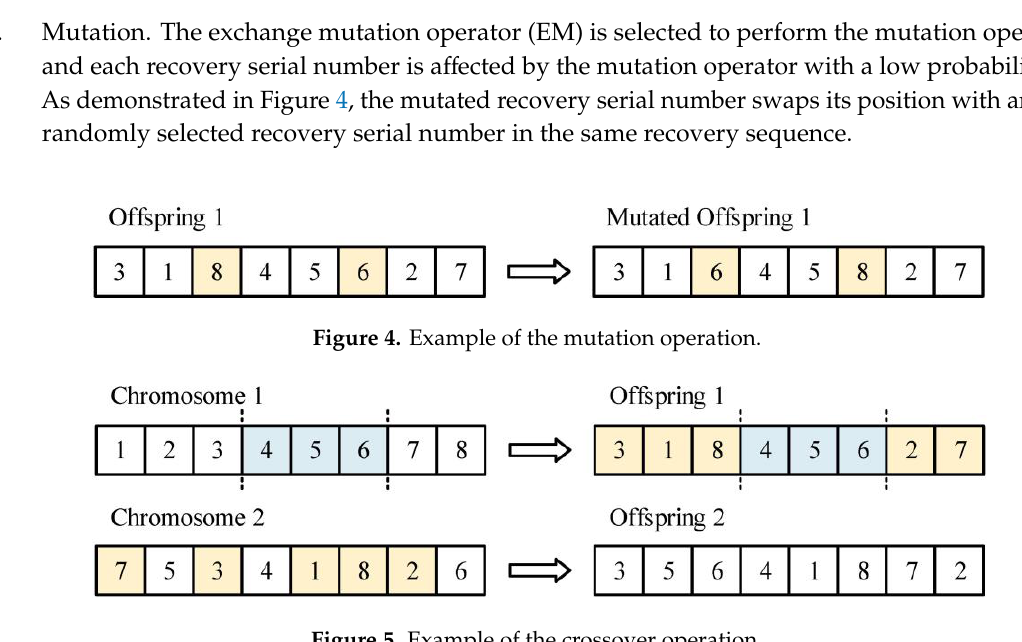
Figure 5. Example of the mutation operation.